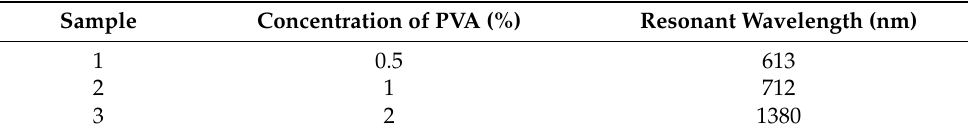
Table 1. Parameters of the three samples used for subsequent tests.